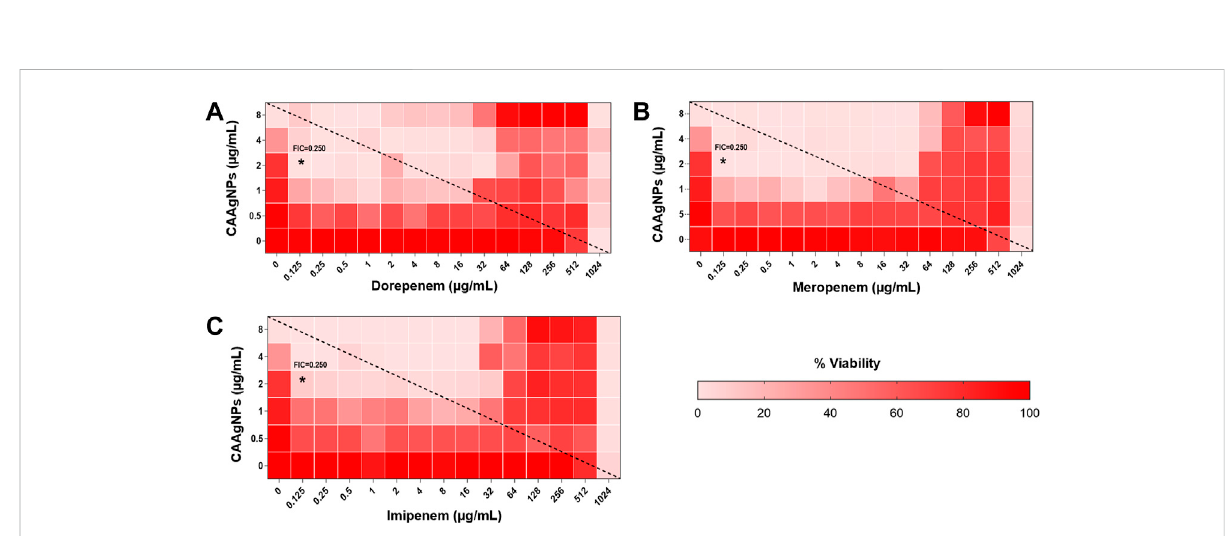
FIGURE 11 Heat plots demonstrating synergistic effect of CAAgNPs in combination with antibiotics against P. aeruginosa PAW1. Representation of normalized values of percent viability after treatment of CAAgNPs (0 – 8 μ g/ml) with (A) dorepenem (0 – 1,024 μ g/ml), (B) meropenem (0 – 1,024 μ g/ ml) and (C) imipenem (0 – 1,024 μ g/ml) respectively. Untreated cells with hundred percent viability indicated by darker red boxes. Lighter red boxes indicate reduced cell viability. Dashed line passes through theMICs and “ * ” (asterisk) below it represents the FICi values suggesting a synergistic